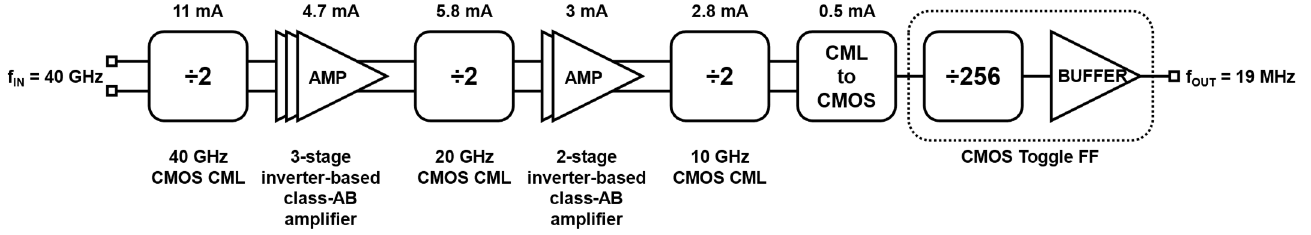
Figure 4. Simplified block diagram of the high ‐ frequency divider chain.